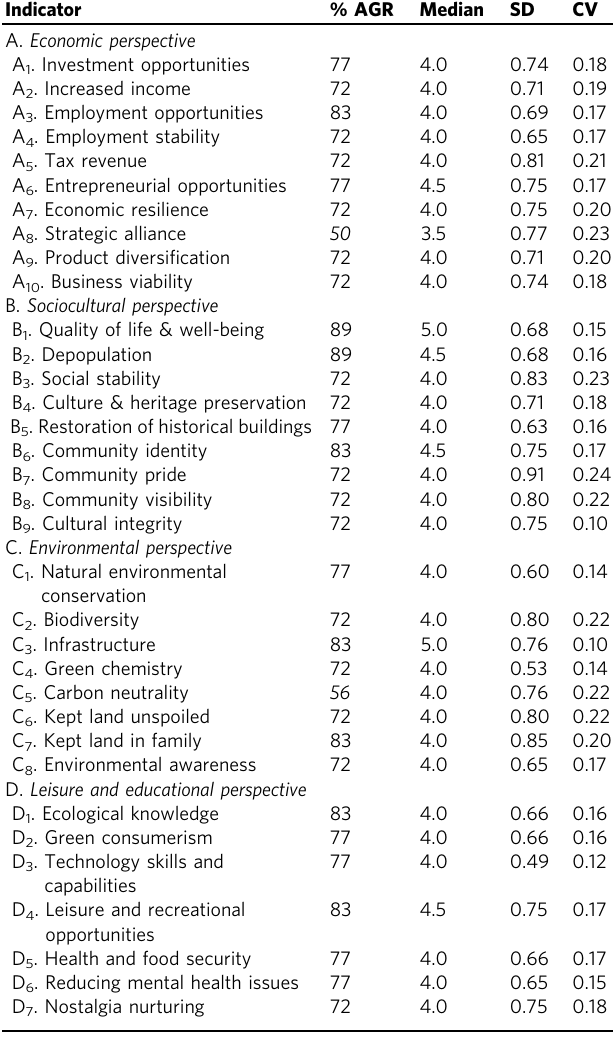
Table 1 Results of interexpert